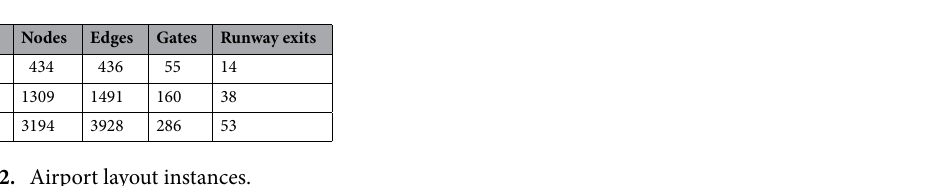
Table 2. Airport layout